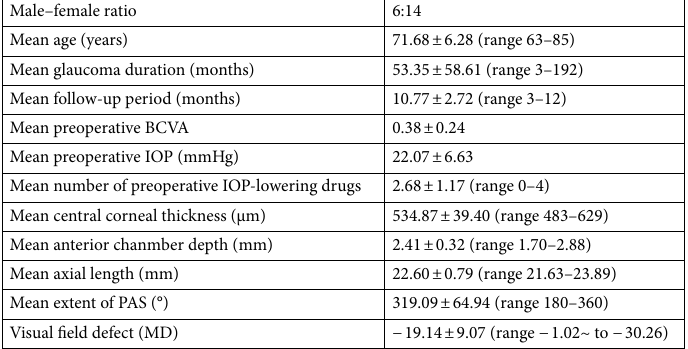
Table 1. Baseline characteristics of all 20 patients (22 eyes). BCVA best corrected visual acuity, IOP intraocular pressure, MD mean deviation, PAS peripheral anterior synechiae.